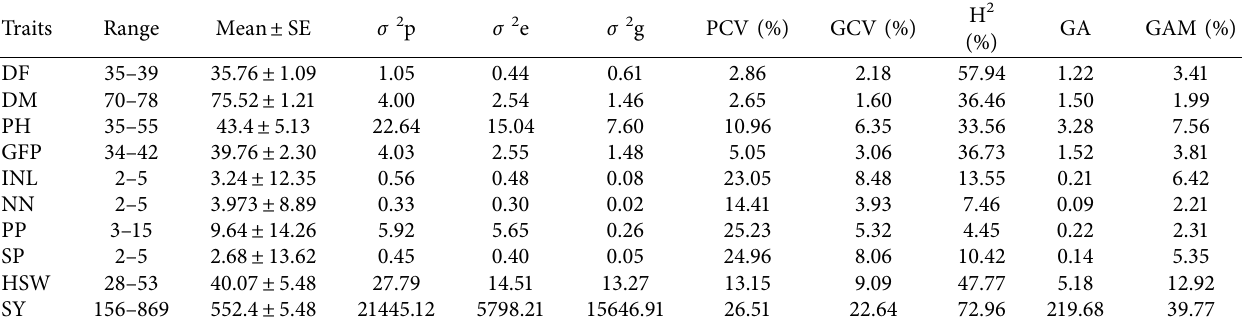
Table 5: Estimate of range, mean, components of variance, heritability, and genetic advance of common bean genotypes at Miesso in 2018 cropping season.